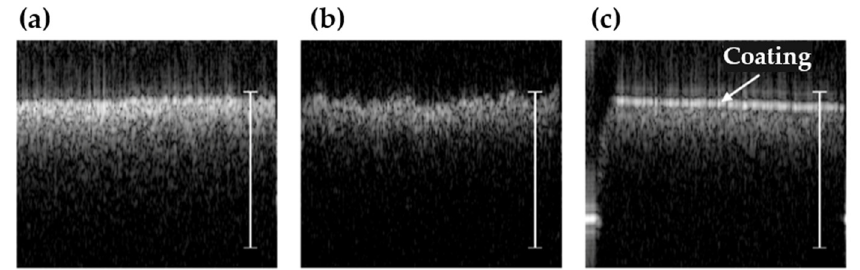
Figure 7. Three paper samples with significantly different surface finishes visualized using OCT. ( a ) Single B-scan of 100- μ m printing paper sample. ( b ) Single B-scan of 443- μ m packaging paper sample. ( c ) Single B-scan of 256- μ m high-gloss paper sample. Scale bars represent 0.5-mm thickness in air.